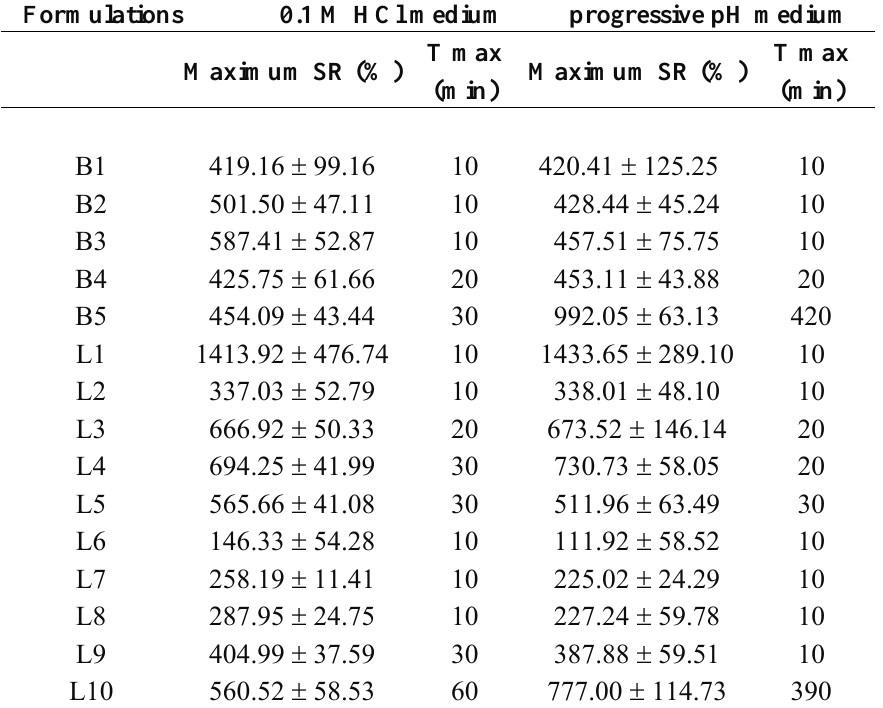
Table 2. Maximum swelling ratios (SR) and the time required for obtaining the values